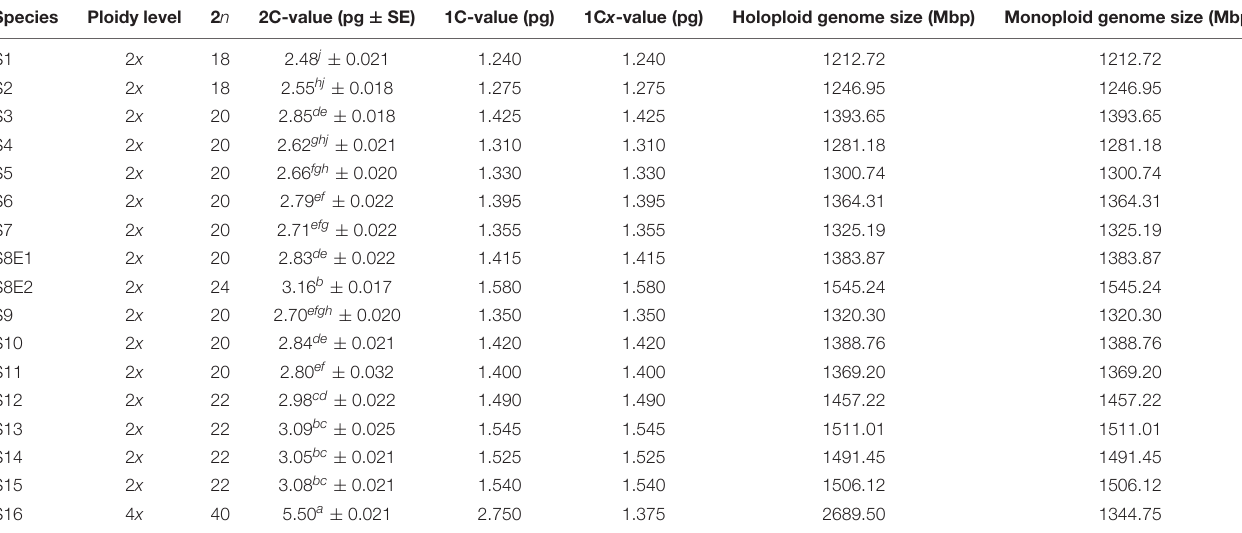
TABLE 3 | 2C-value and flow cytometric DNA estimation data of Pimpinella species. Species Ploidy